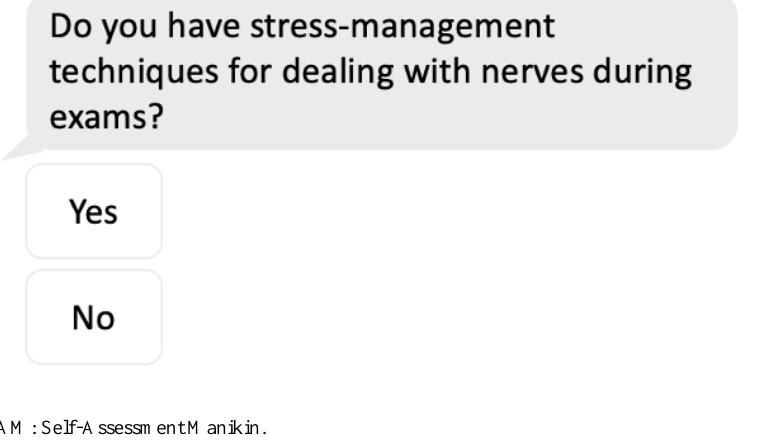
Figure 3. Study procedure. SAM: Self-Assessment